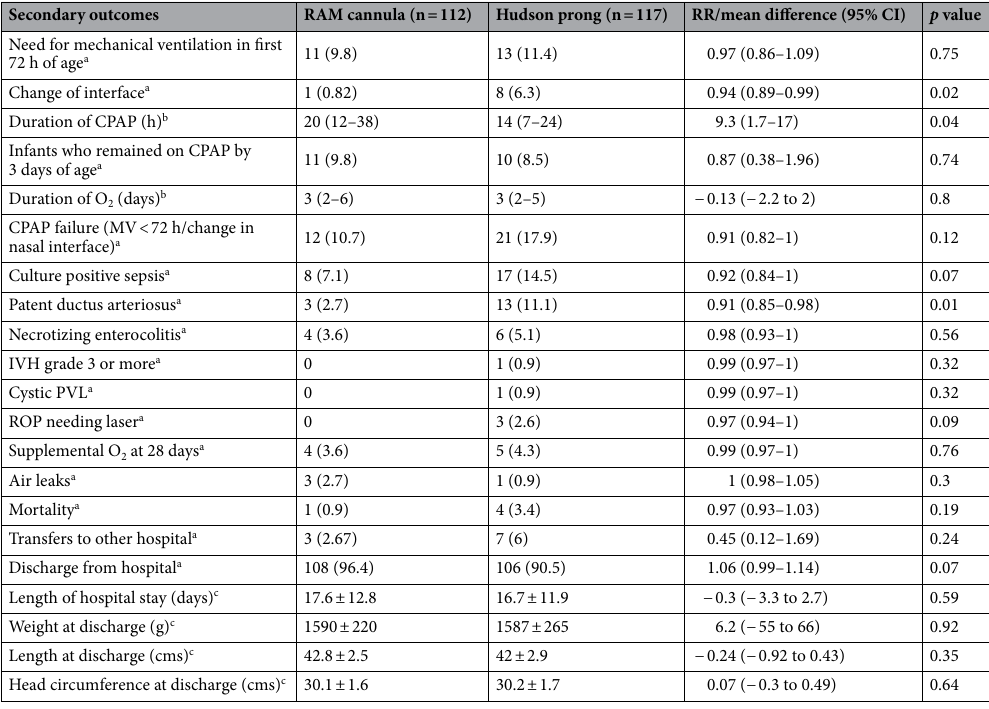
Secondary outcomes RAM cannula (n = 112) Hudson prong (n = 117) RR/mean difference (95% CI) p